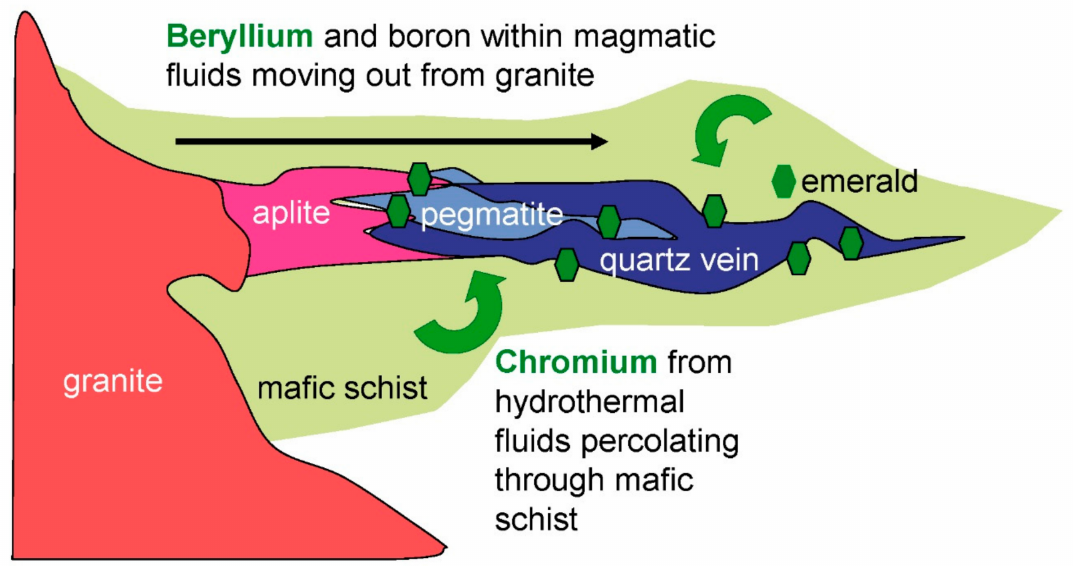
Figure 18. Genetic model proposed for the emerald mineralization at Tsa da Glisza, Yukon Territory, Canada.